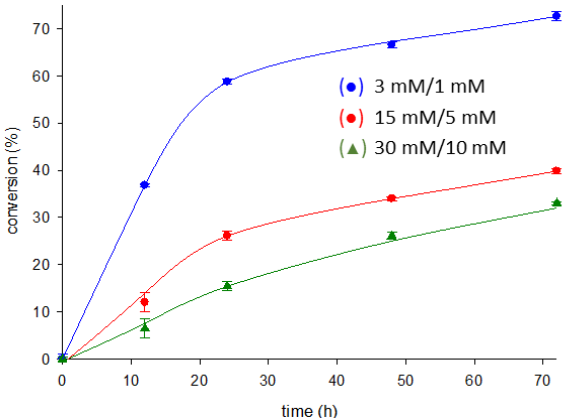
Figure 7. Time–course of the enzymatic production of nelarabine catalyzed by Ld NDT S104C at differ- ent substrate concentrations: ara U (3–30 mM) and 6-MeOGua (1–10 mM). All determinations were carried out in triplicate, and the standard error of the mean is calculated using the standard devia- tion.